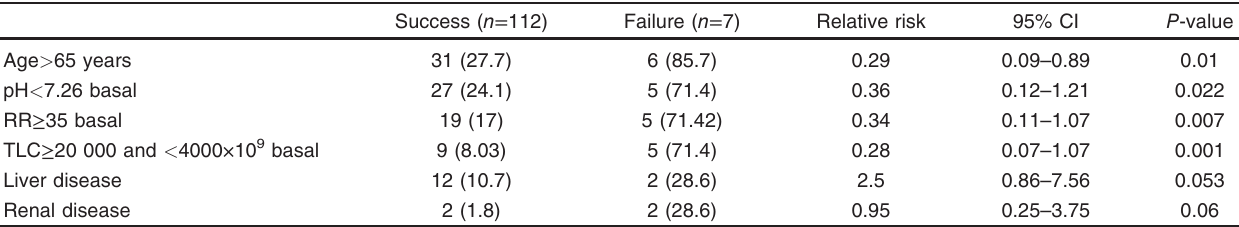
Table 8 Multivariate analysis of the different parameters in the success and failure groups